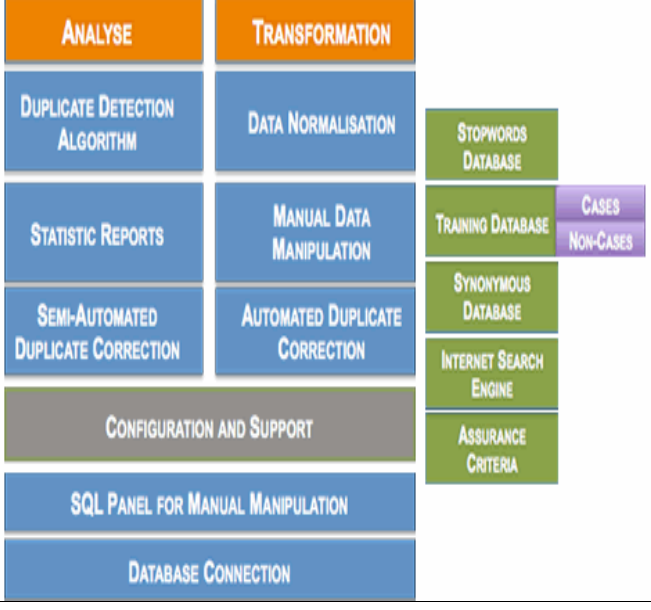
Figure 1: Architecture of developed data cleaning environment. Source: Authors,